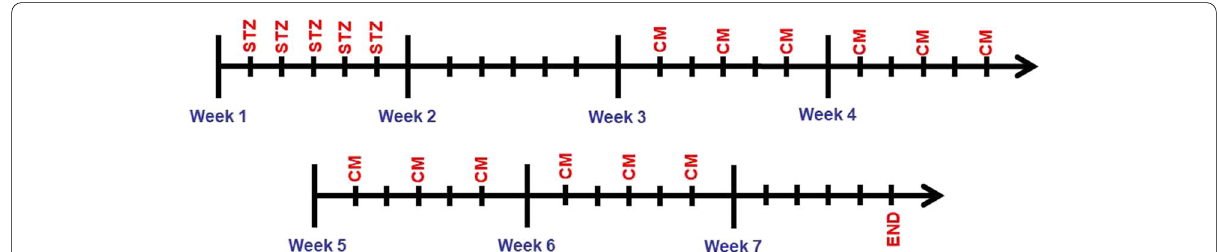
Fig. 1 Timeline of disease modeling and treatment